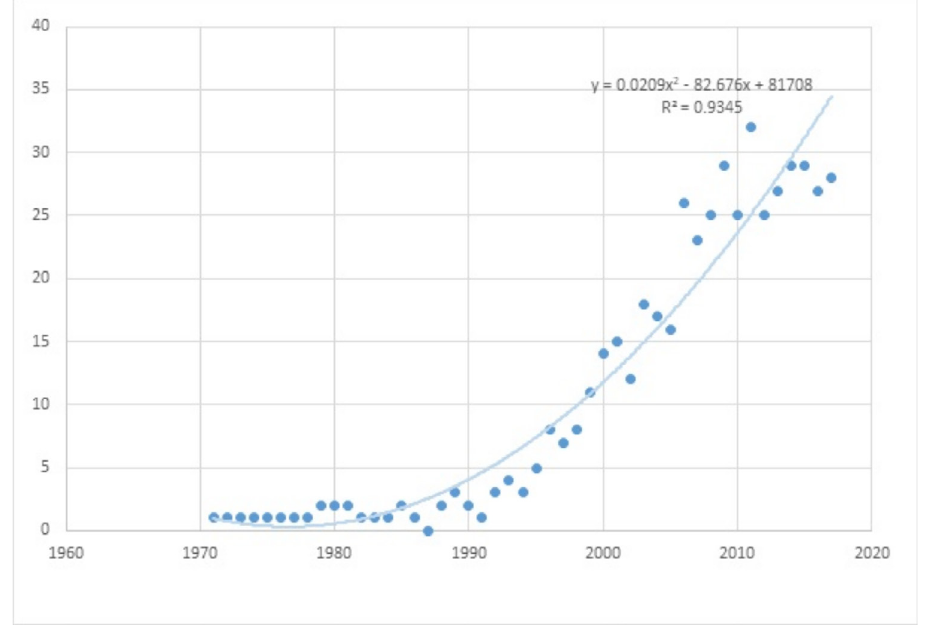
Figure 3: Number of research actors by year, with its moving average trendline (1971-2017 in